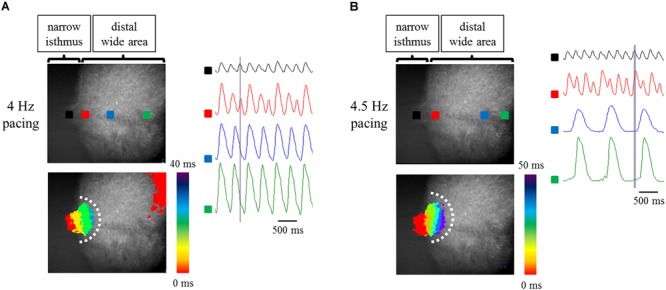
(A,B) Optical mapping of a narrow isthmus model containing 70% atrial-like hiPSC-CMs and 30% Fbs under constant pacing at 4 Hz (A) and 4.5 Hz (B). Omnidirectional block was observed (A,B). (Upper left panel) The recorded field in the preparation. OAP waveforms were acquired at each ROI as indicated by a solid square. (Lower left panel) Activation map on the recorded field during the time range denoted by the light purple rectangle in the right panel. White dotted line indicates the estimated conduction block line. Color bar denotes total activation time (ms). (Right panel) Representative OAP waveforms acquired at each ROI as indicated by a solid square in the upper left panel. Light purple rectangle designates the time range during which the activation map was developed. Time scale bar, 500 ms.